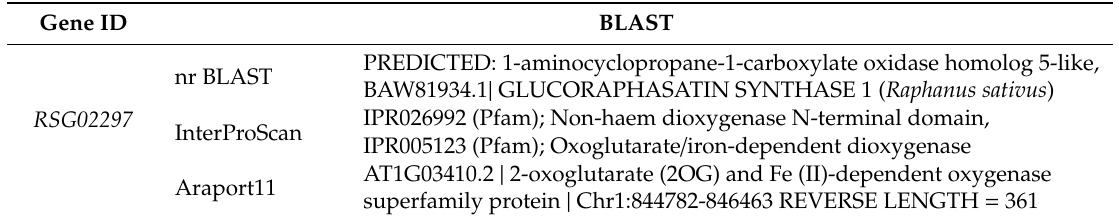
Table 3. Functional annotation for the GRS1 gene ( RSG02297 ) in a public